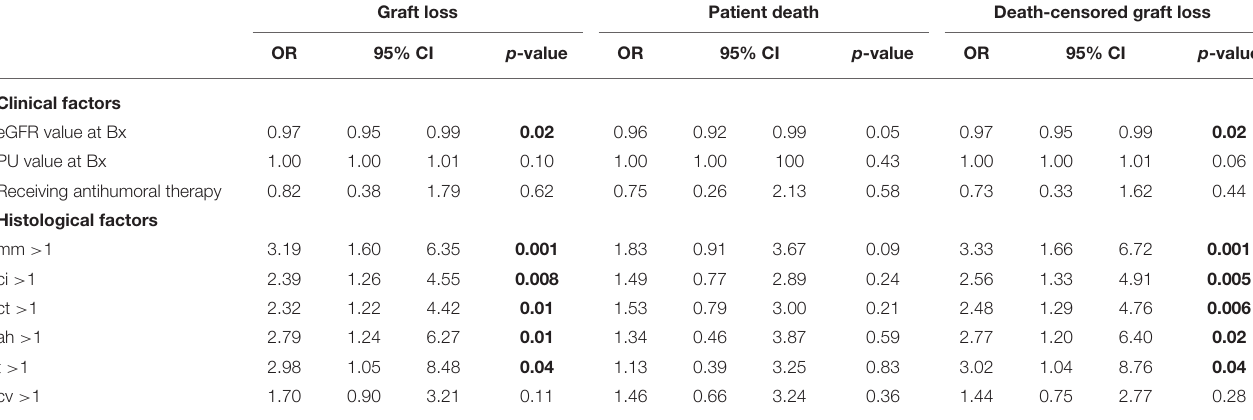
FIGURE 3 | The comparison of 5-year graft survival (left) , death censored graft survival (middle) and 5-year patient survival (right) among iTG, cAMR and cAAMR groups. Bx, the studied biopsies.